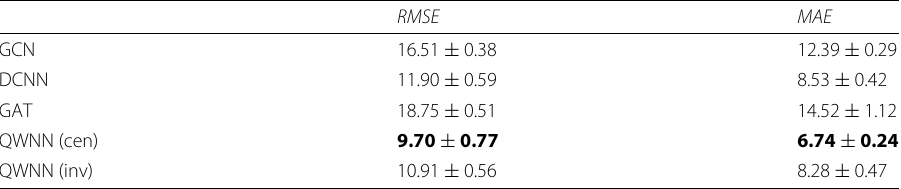
Table 3 Atomization energy prediction